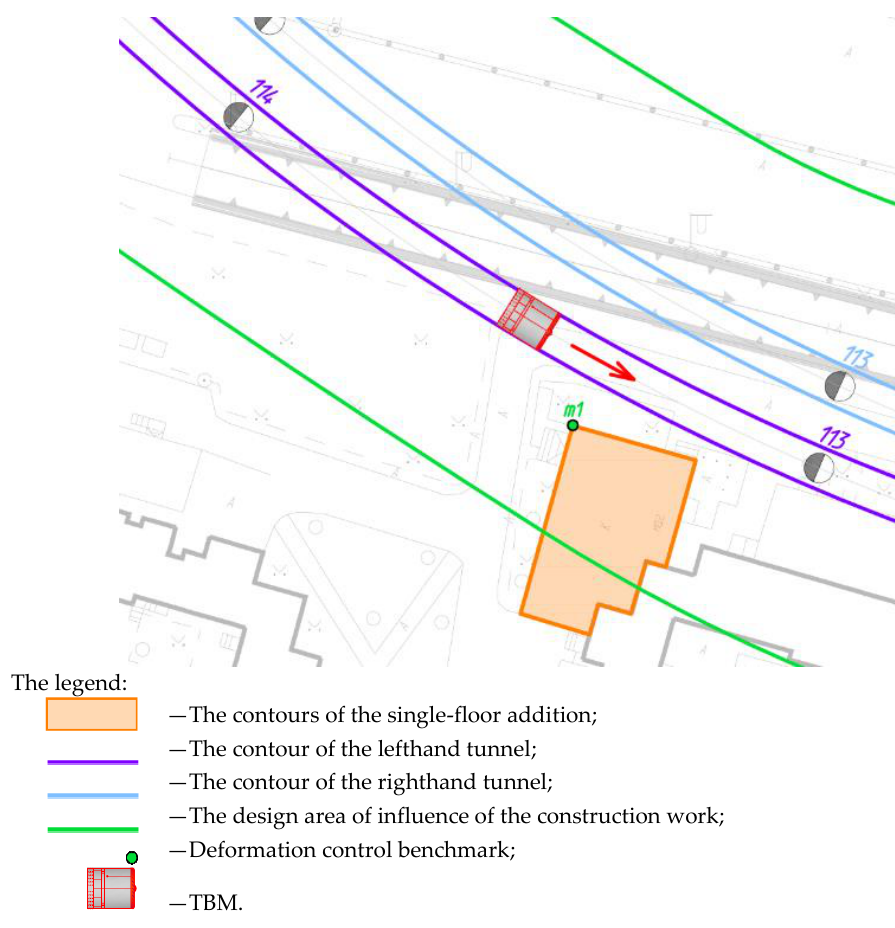
Figure 3. Fragment of the PK113-PK114 plan, including the building and the relative position of the designed tunnel. Table 2. Monitoring data and tunneling parameters.